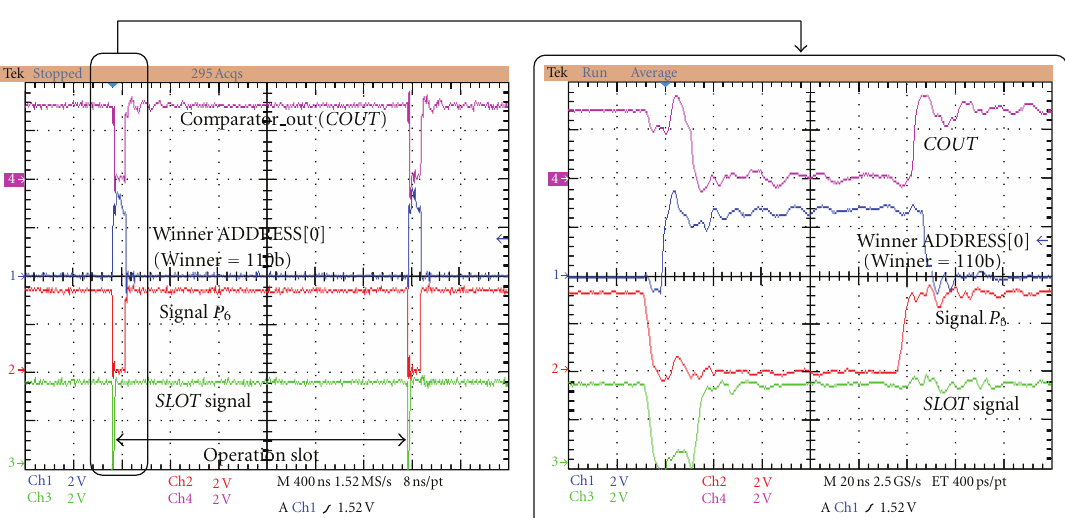
F 7: Pattern for